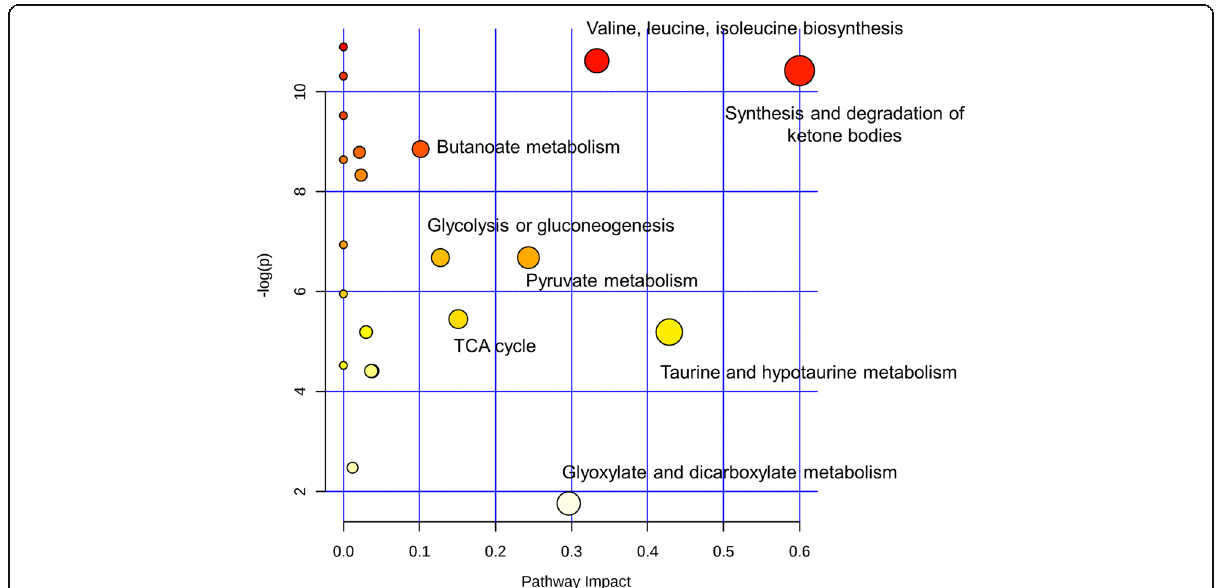
Fig. 7 Summary of pathway analysis with